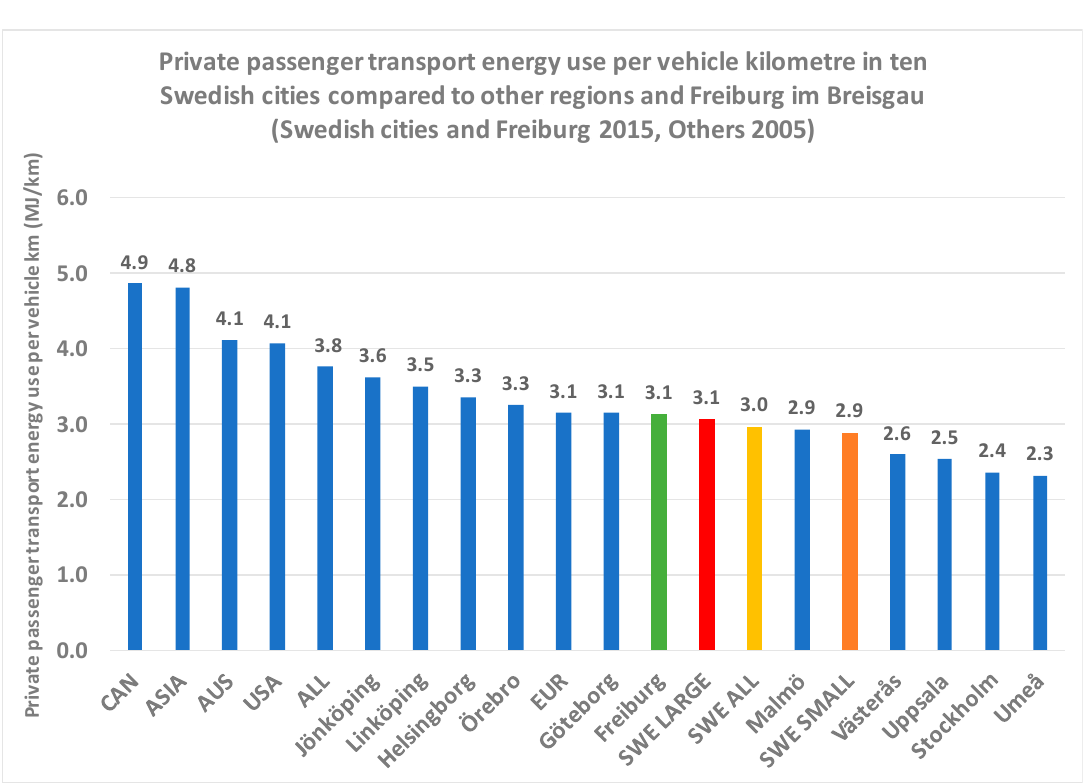
Figure 3. Energy use per vehicle kilometer in private passenger transport in ten Swedish cities (2015); Freiburg (2015); and American, Australian, Canadian, European and Asian cities (2005–2006).